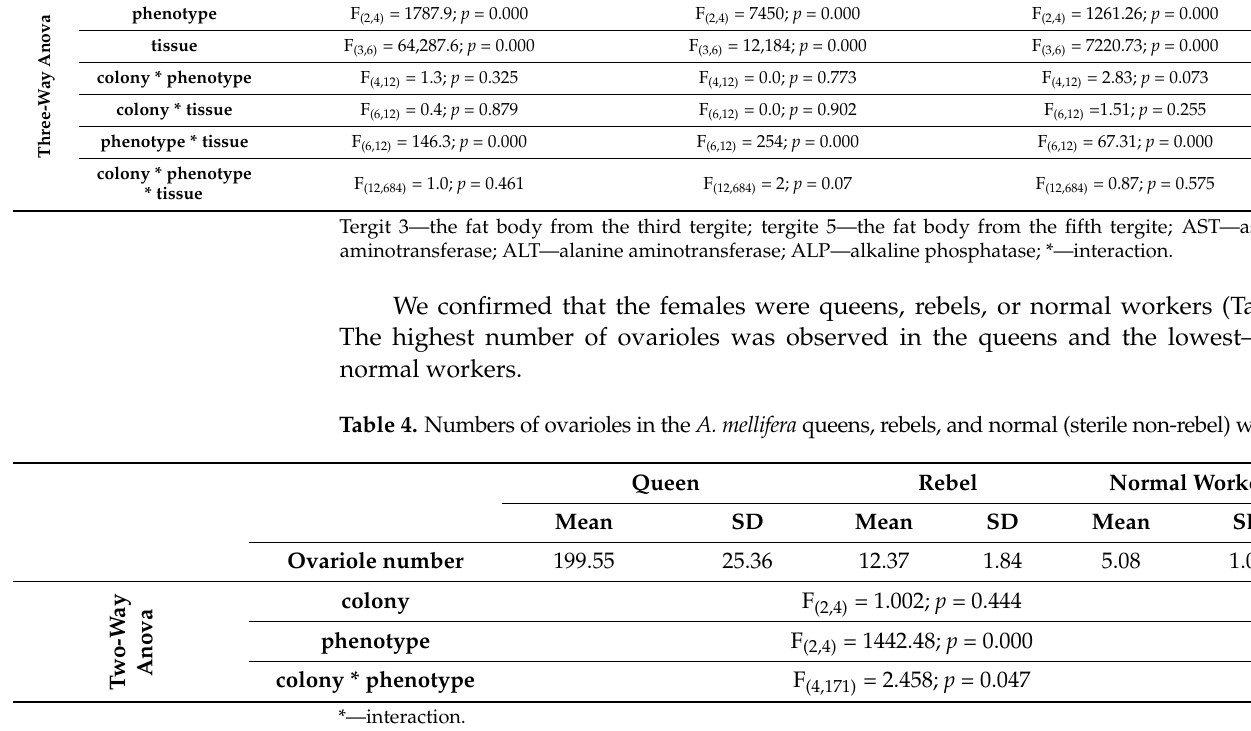
Table 3. Activities of biomarkers in the fat body and hemolymph of the A. mellifera queens, rebels, and normal (sterile non-rebel) workers. Normal Queen Rebel Workers